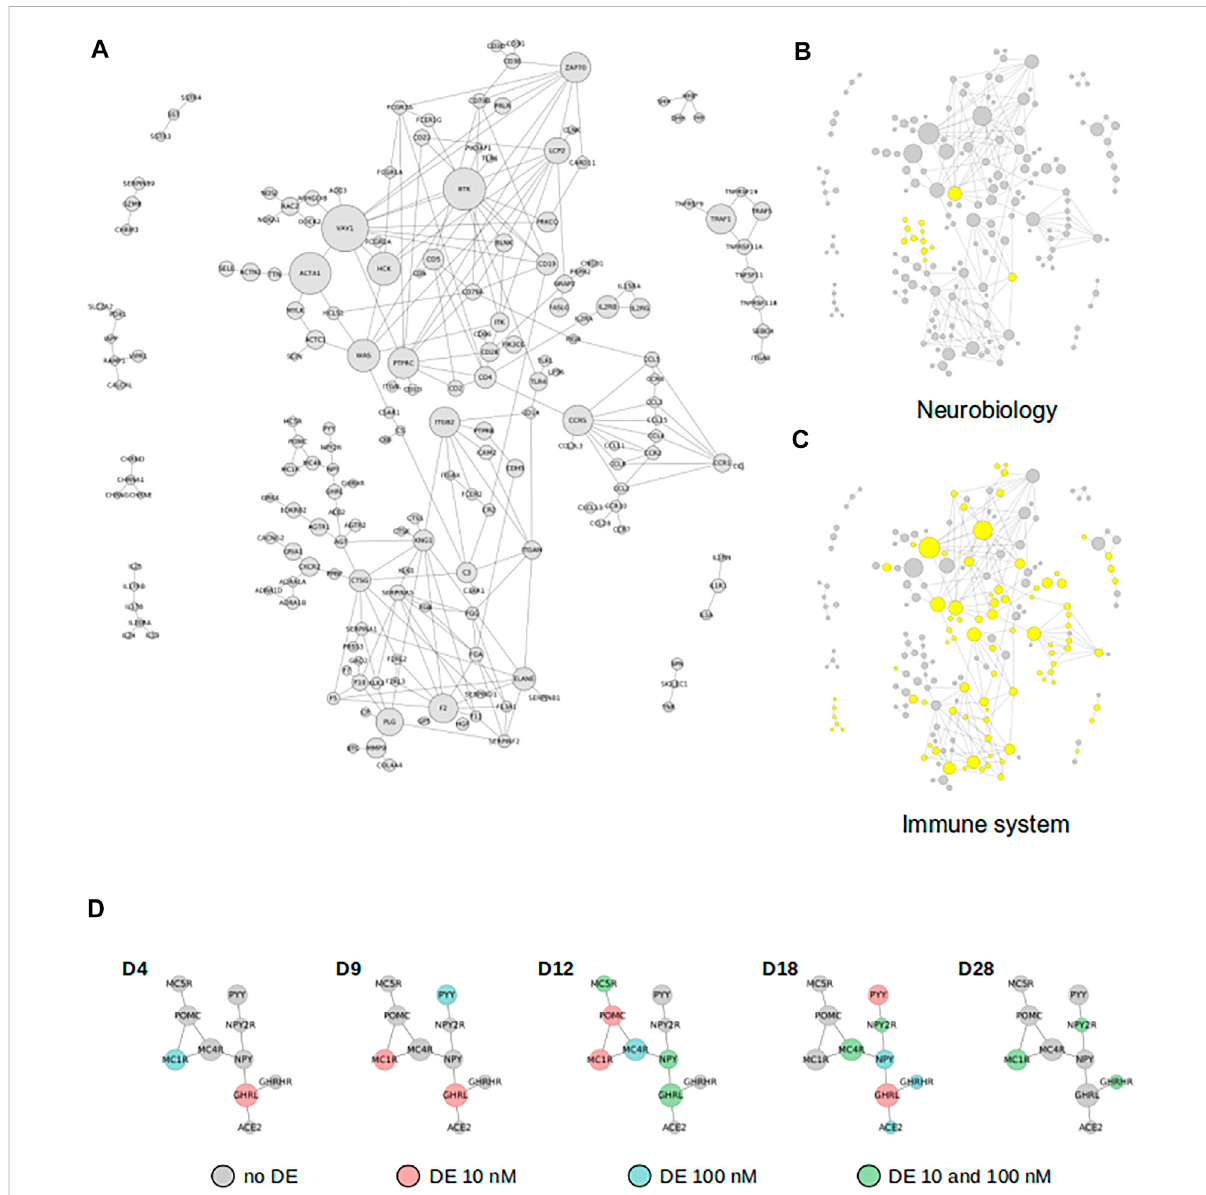
FIGURE 4 DE genes functionally cooperate with each other. (A) Subnetwork depicting the functional interactions between DE genes. (B,C) Genes related to neurobiology or immune system are highlighted in yellow, respectively. (D) Temporal dynamic of the subnetwork where most of genes (8 out of 10: Pomc , Mc4r , Pyy , Npy2r , Npy , Ghrl , Ghrhr and Ace2 ) are highly expressed in central nervous